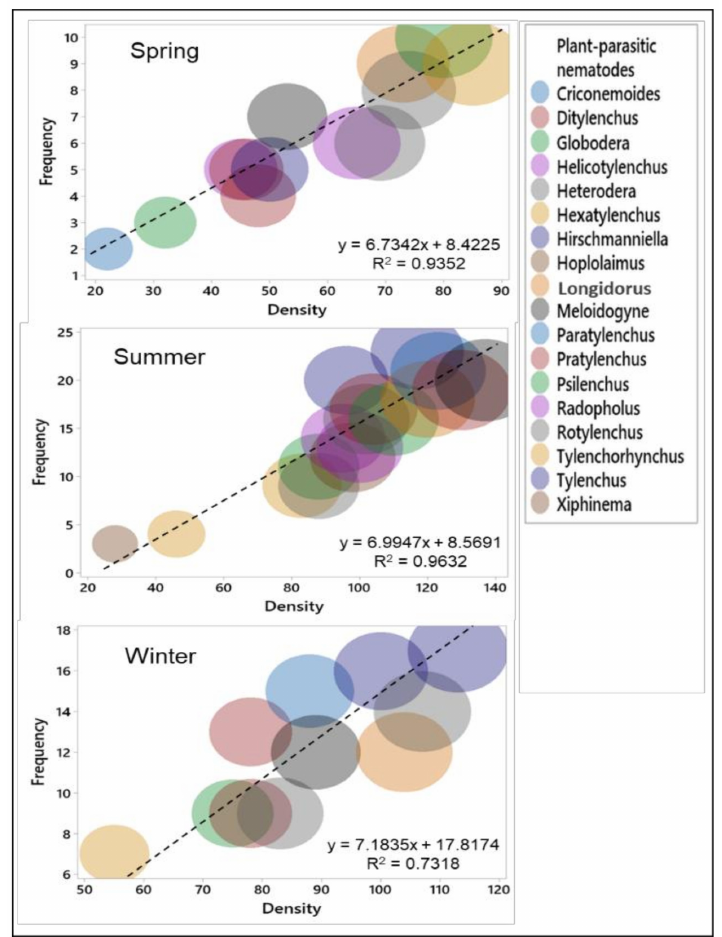
Figure 6. The changes in plant-parasitic nematode diversity of the soil during the spring, summer, and winter seasons in the rice fields. Linear trendlines were obtained from mean data of the frequency and the density of the soil PPN genera; R 2 represents the correlation strength in the three